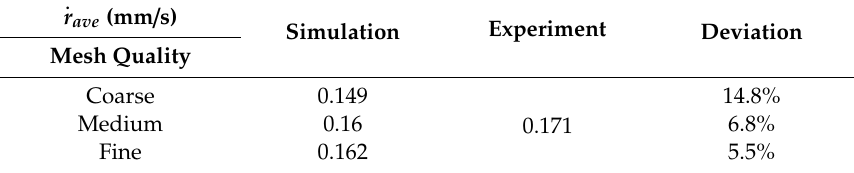
Table 3. Deviation analysis of average regression rate of di ff erent mesh number.